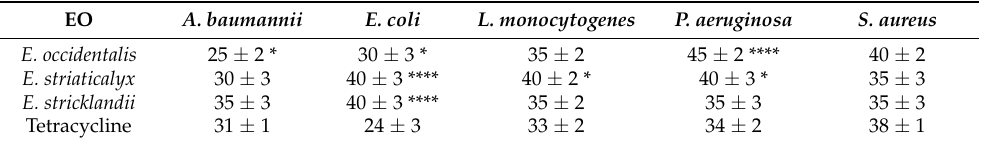
Table 5. MIC ( µ L/mL) of the EOs necessary to inhibit the growth of A. baumannii , E. coli , L. monocyto- genes, P. aeruginosa and S. aureus . Tetracycline was used as positive control. EO